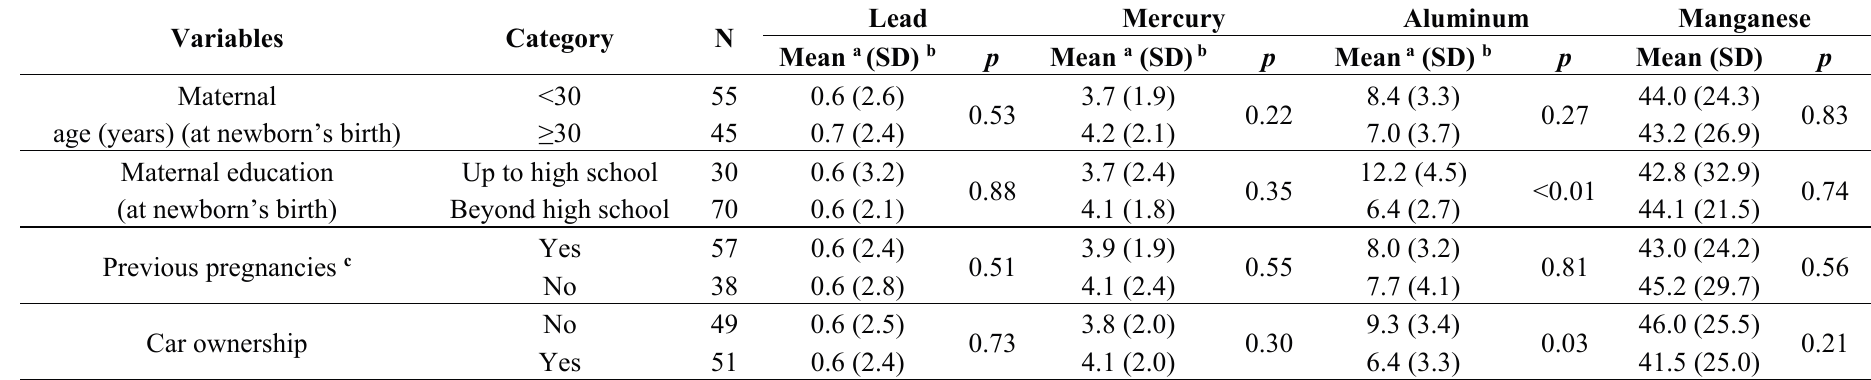
Table 4. Univariable association of cord blood metal concentrations with mother’s individual and household characteristics as potential confounding variables based on data from n = 100 newborns.